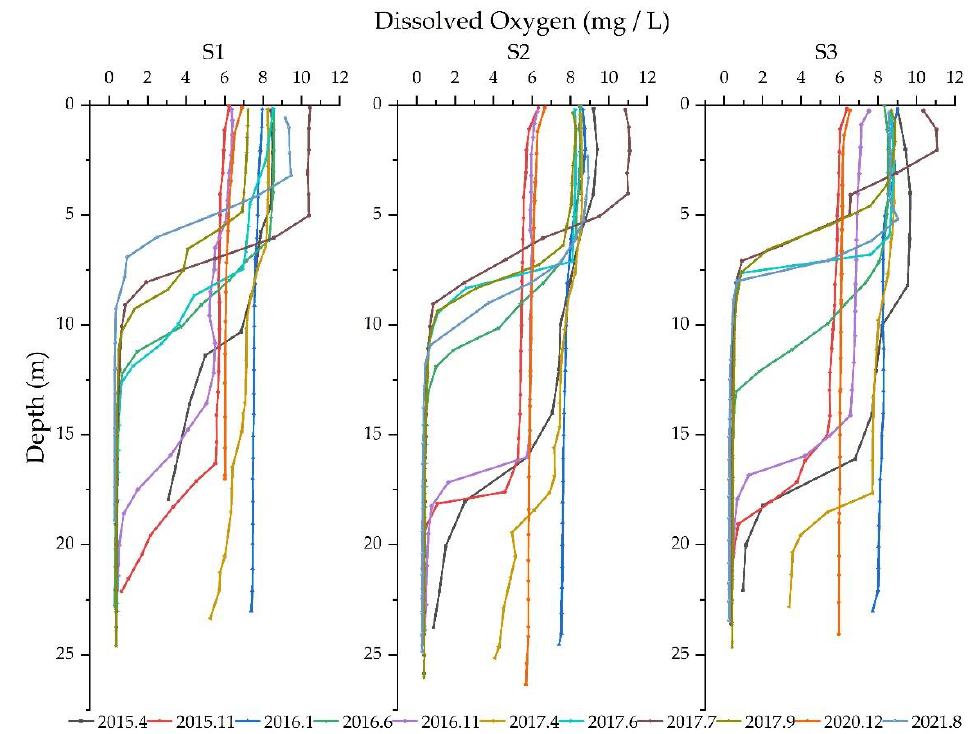
Figure 3. Vertical profile of dissolved oxygen (DO) in Lake Yangzong.